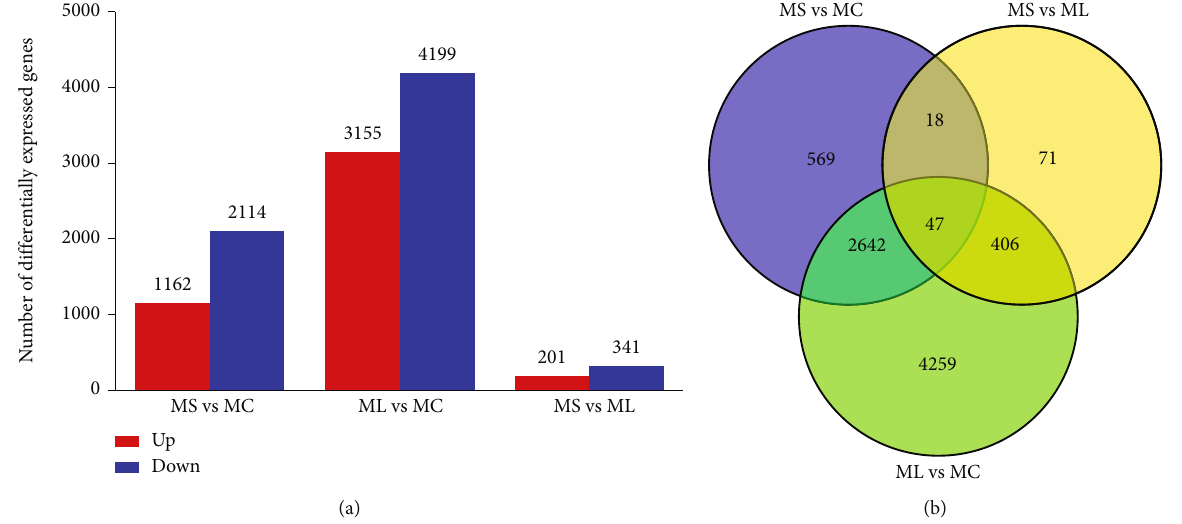
Figure 6: Di ff erentially expressed genes (DEGs) pro fi le of the muscle samples of Synechogobius hasta subjected to starvation. Bar graph (a) and Venn diagram (b) of DEGs between the di ff erent pairwise comparisons. MC: muscle in the control group (continuously fed for 14 days); MS: muscle in the starved group (starved for 3 days); ML: muscle in the starved group (starved for 14 days). Three replicates were used for each group in the transcriptome analysis. A subset of genes with P < 0 : 05 and j log 2 ð foldchange Þj ≥ 1 is shown as the overlapped area in the Venn